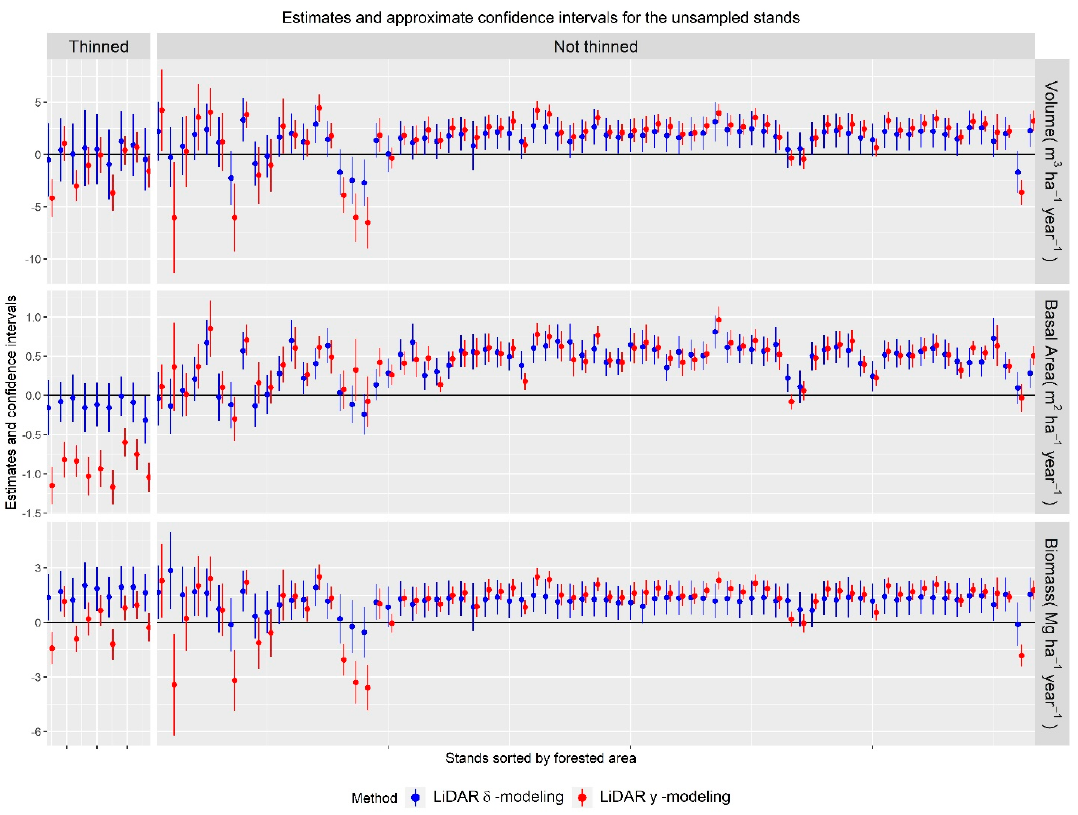
Figure 3. Estimates of V, BA and B change for the unsampled stands of Blacks Mountains Experimental Forest. LiDAR-derived estimates using the δ -modeling method are indicated by blue dots and LiDAR-derived estimates obtained using the y -modeling method are indicated with red dots. Thinned stands are to the left and non-thinned stands to the right.